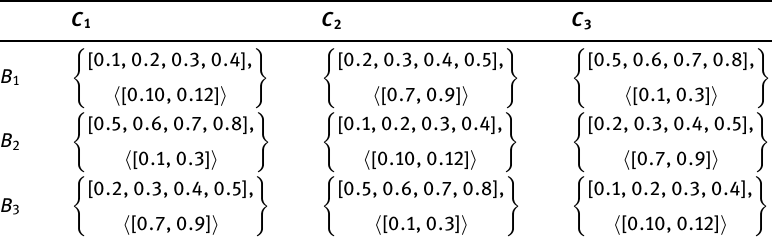
Table 6: Intuitionistic Trapezoidal Fuzzy Decision Matrix. C 1 C 2 C 3